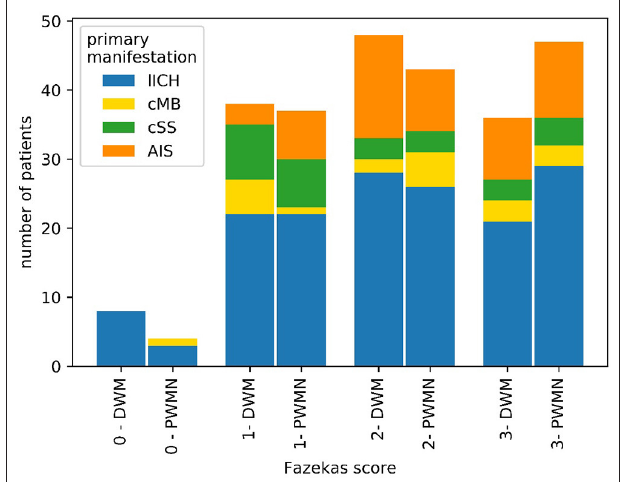
FIGURE 5 | Distribution of Fazekas scores among patients with CAA with MRI. Overall, a Fazekas score of 0 was less common than scores of 1–3 for both periventricular white matter lesions (PWML) and deep white matter lesions (DWL).